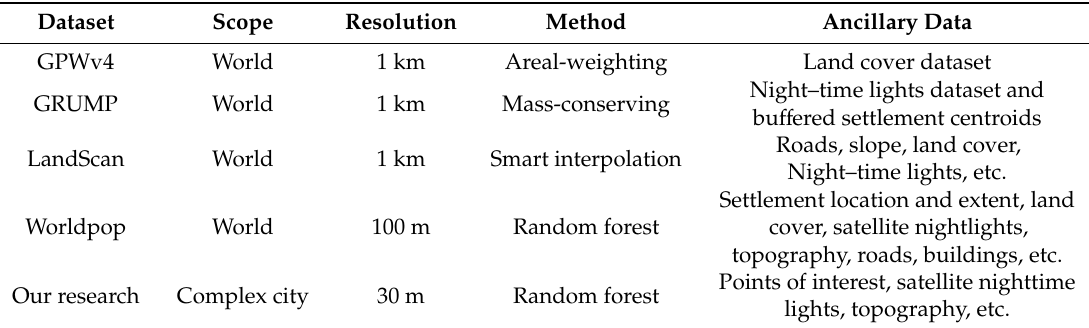
Table 1. List of population mapping